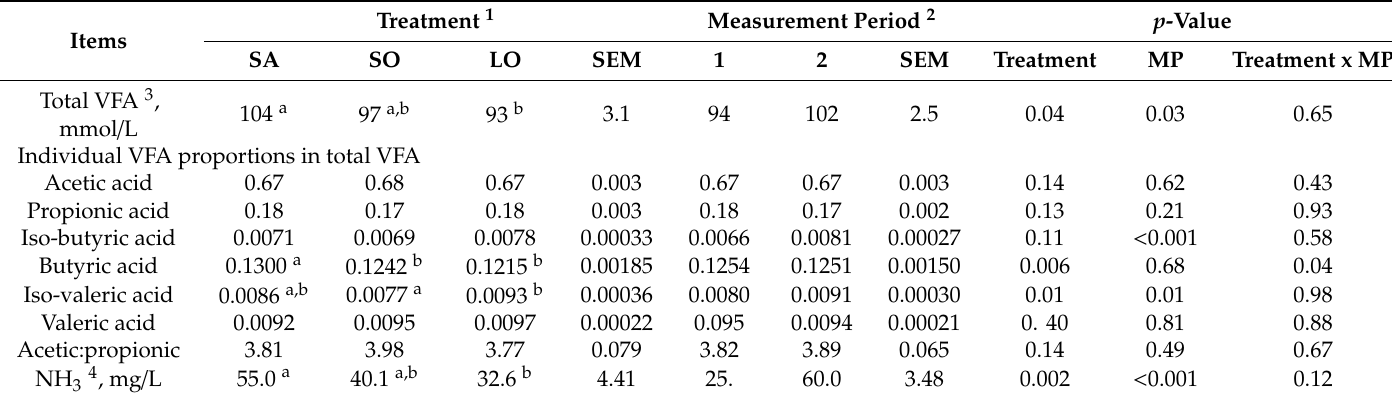
Table 6. E ff ect of C 18 fatty acid source in the supplementary concentrate and measurement period on rumen fermentation parameters of lactating dairy cows o ff ered a pasture based diet (least square means ±